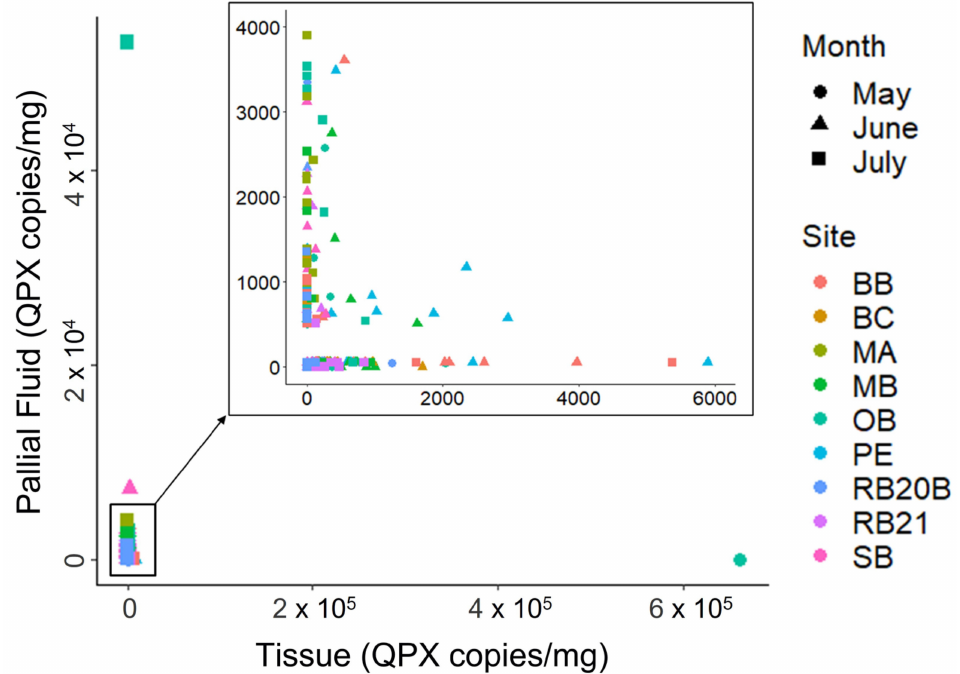
Figure 4. M. quahogii (QPX) in hard clam pallial fluid and tissue for each individual clam. Negative samples were assigned a value of 0 and BLD samples were assigned 10% of the qPCR assay’s limit of detection (LOD) for the specific sample type (50 copies/mL for pallial fluid BLD and 7.5 copies/mg for tissue BLD) for